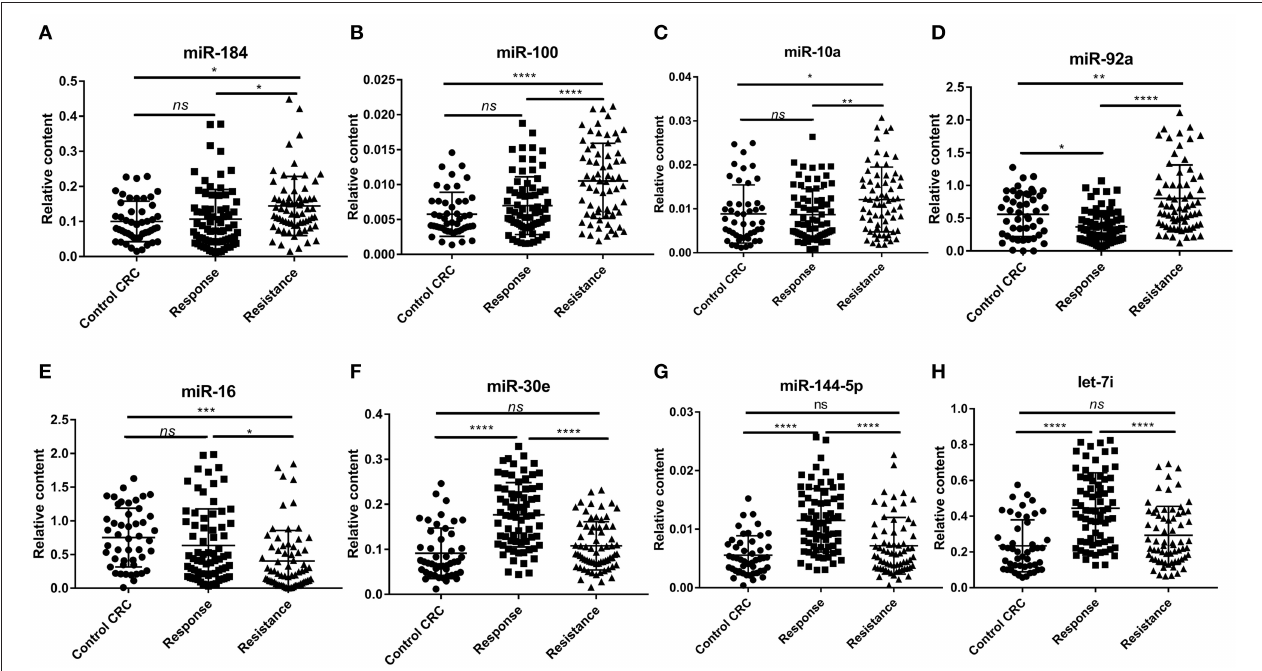
FIGURE 4 | The relative expression of plasma exosomal miRNAs in the control CRC group ( n = 47), response group ( n = 72), and resistance group ( n = 67). (A) Relative expression of plasma exosomal miR-184. (B) Relative expression of plasma exosomal miR-100. (C) Relative expression of plasma exosomal miR-10a. (D) Relative expression of plasma exosomal miR-92a. (E) Relative expression of plasma exosomal miR-16. (F) Relative expression of plasma exosomal miR-30e. (G) Relative expression of plasma exosomal miR-144-5p. (H) Relative expression of plasma exosomal let-7i. Statistics were analyzed by one-way ANOVA, data was shown as mean ± SD. * P < 0.05, ** P < 0.01, *** P < 0.001, **** P <